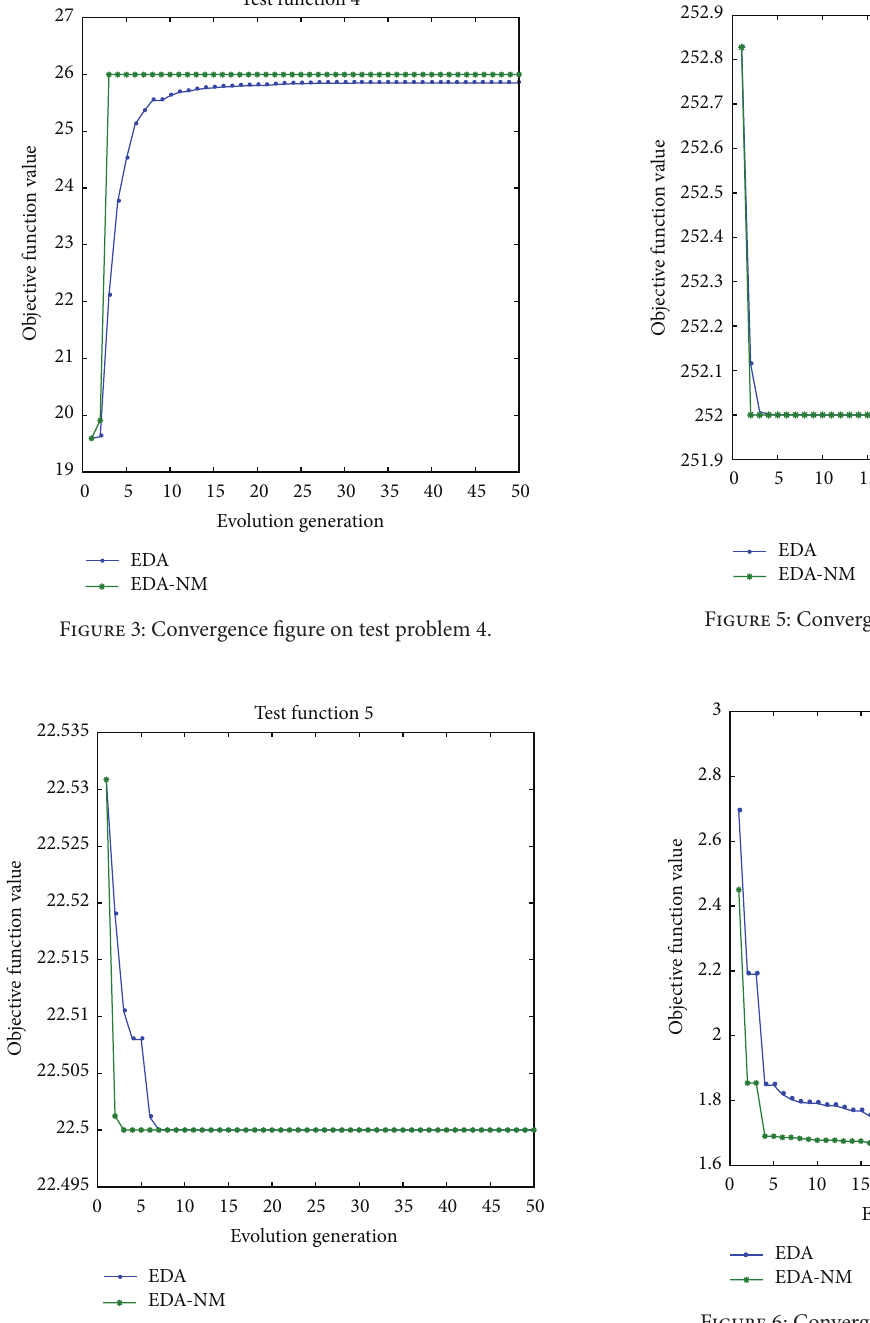
Figure 4: Convergence figure on test problem 5.